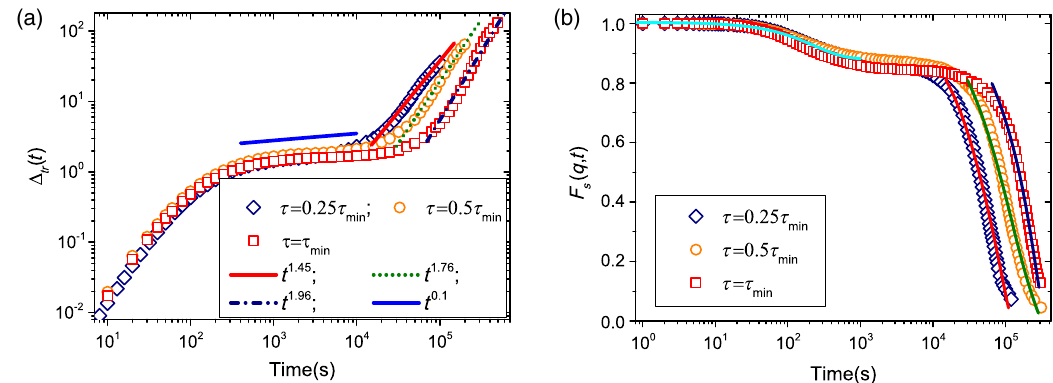
FIG. 9. Dynamics of the tracers at different cell cycle times. (a) Time dependence of Δ ð t Þ of tracer cells at different cell division times τ . Fits to Δ ð t Þ at intermediate and long times are shown in the inset. (b) The self-intermediate scattering function F q; t Þ are shown by solid Exponential fits to the decay of tracer F s ð